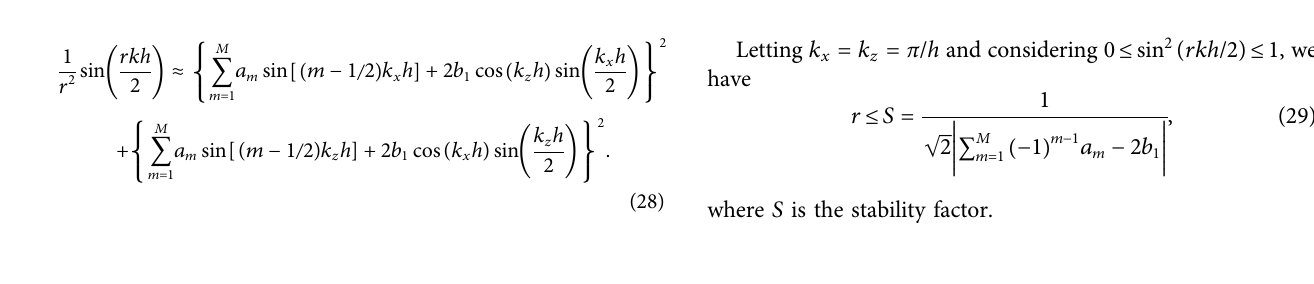
Frontiers in Earth Science |